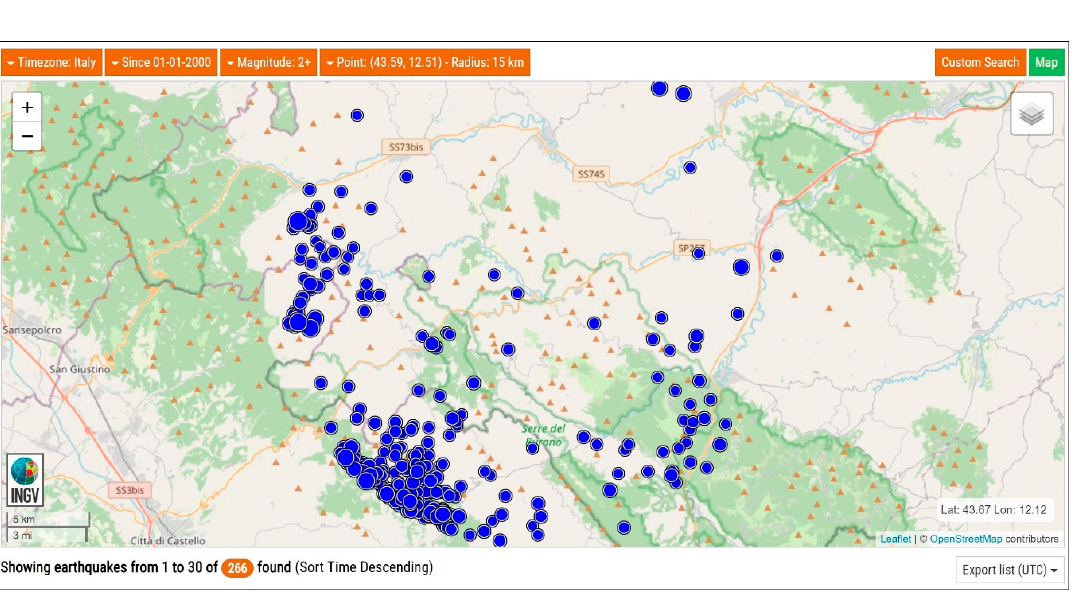
Figure 13. Map of the search results showing the locations of earthquakes around the study area over the last 20 years from the Institute of Geophysics and Vulcanology (INGV) web catalog (http://terremoti.ingv.it/en/).